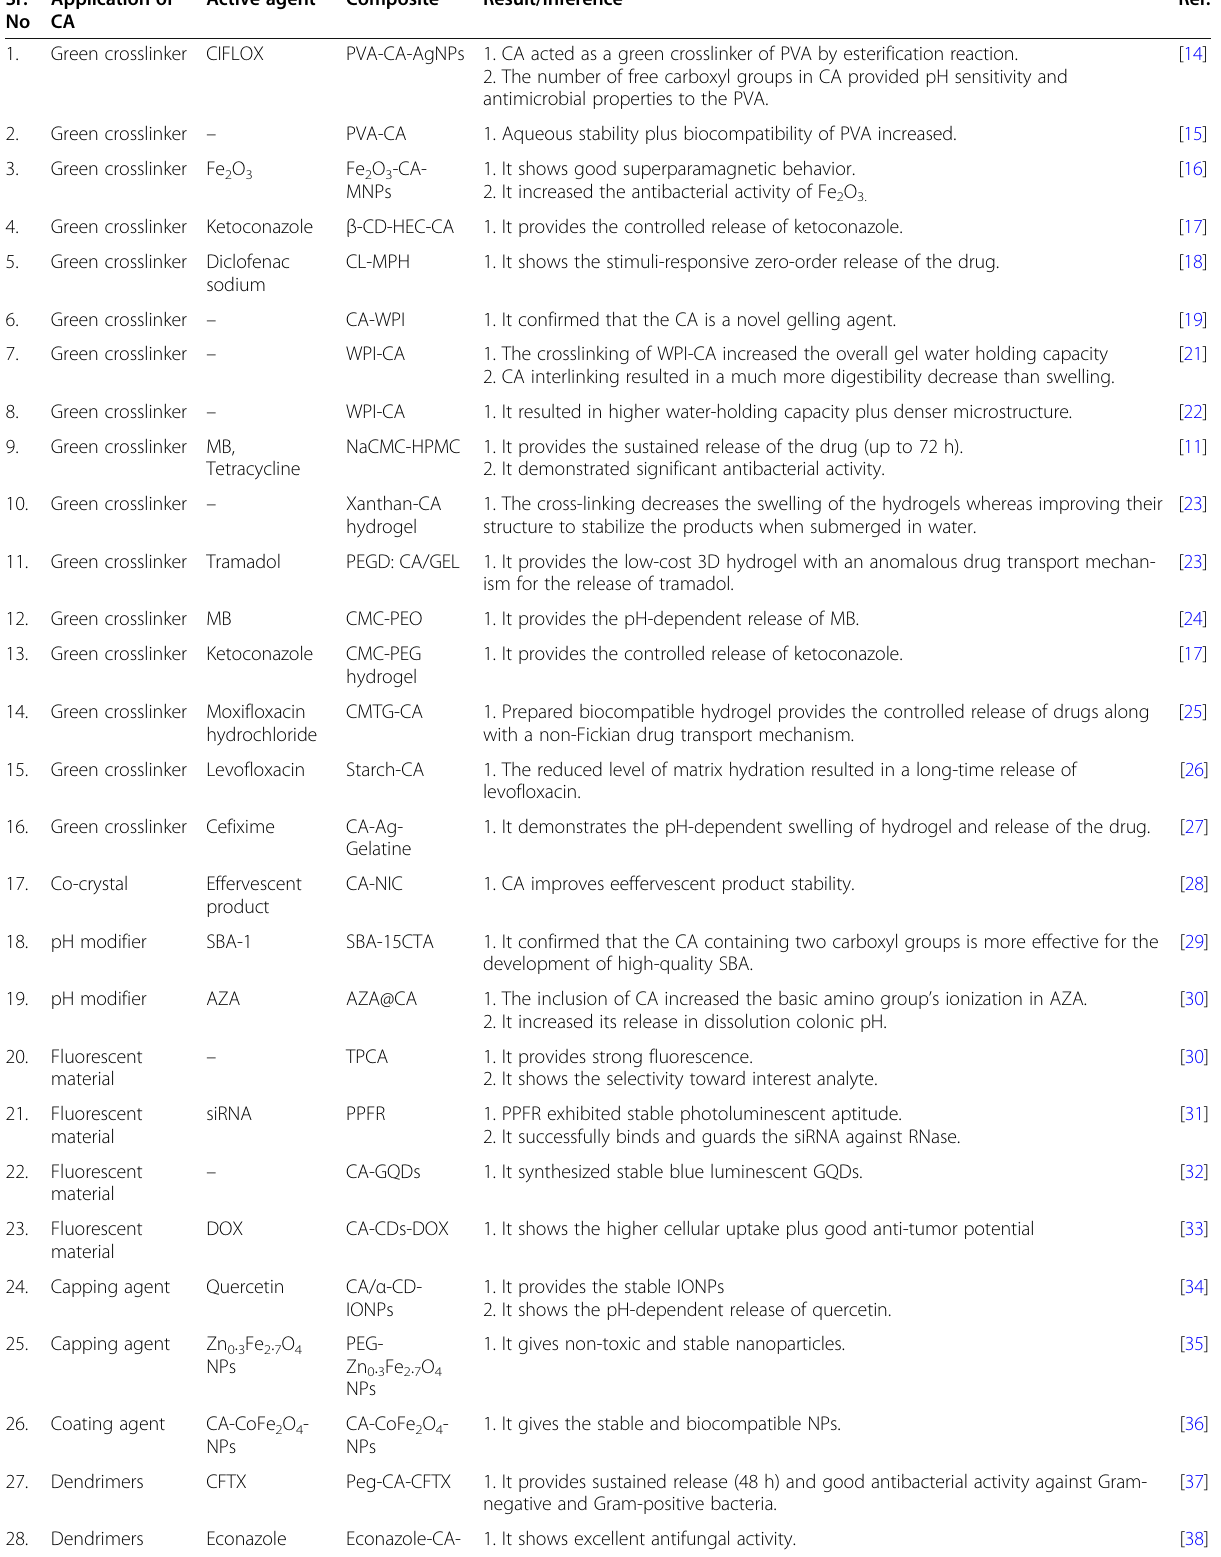
Table 1 Summary of pharmaceutical applications of